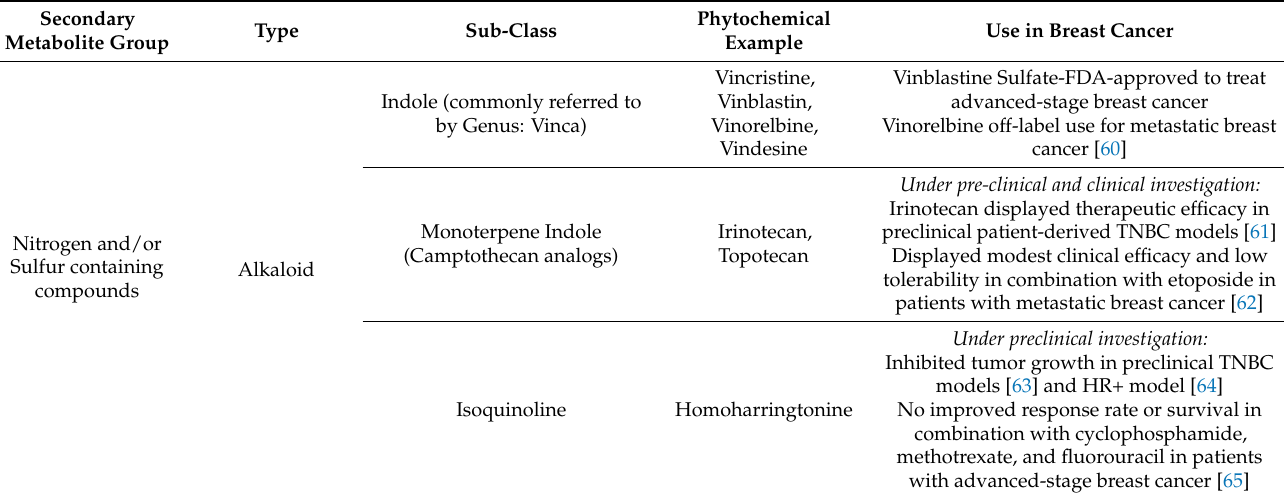
Table 1. FDA-approved phytochemical anti-cancer